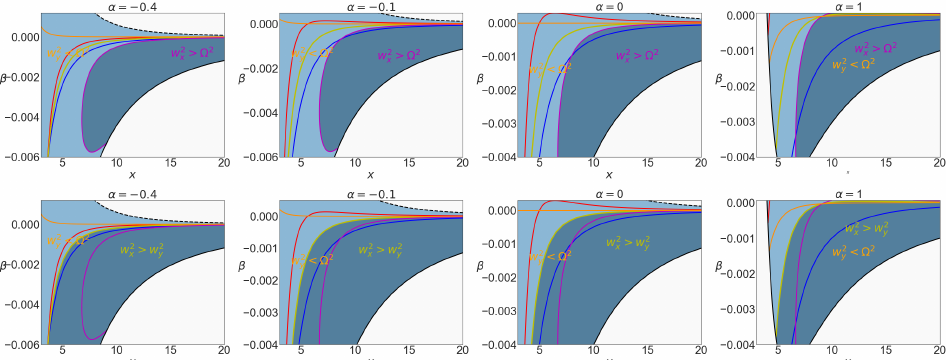
Figure 7. The different epicyclic frequencies in the ( x , β )-plane are examined. As in Figures 4 and 5, the red line shows w 2 x = 0 and the blue line w 2 y = 0. On all plots, the yellow line depicts w 2 x = w 2 y , the pink line shows w 2 x = Ω 2 , and the orange line is w 2 y = Ω 2 . The light blue area corresponds, as in Figures 4 and 5, to the area where circular orbits exist (bounded by the thick black line 2 S − x = 0 and the dashed line S = 0). Between the blue and the red line, when the red line is above the blue one, orbits are stable with respect to the perturbations in both directions. In this panel, in the first row, the darker blue area satisfies w 2 x > Ω 2 . In the second row, the darker blue area satisfies w 2 x > w 2 y . By considering the first and second rows together, one can have different ordering for these